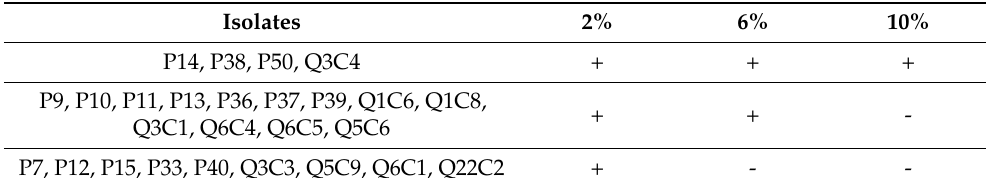
Table 2. Salt tolerance of LAB strains. Isolates